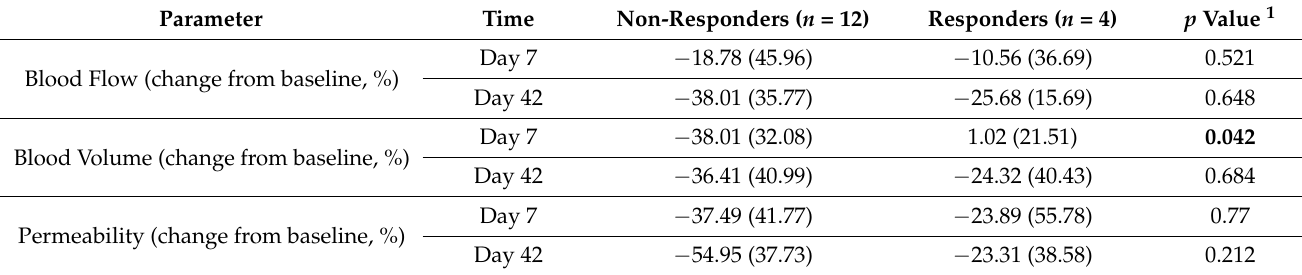
Figure 6. Axial thoracic CT of a 52-year-old man with stage IVa NSCLC showing a lung tumor in the right upper lobe, at baseline ( A ), day +7 ( E ), and day +42 ( I ). Perfusion CT of the lesion with parameters: Blood Flow, BF, (mL/100 mL/min) at baseline ( B ), day +7 ( F ), and day +42 ( J ); Blood Volume, BV, (mL/100 mL) at baseline ( C ), day +7 ( G ), and day +42 ( K ); Permeability, PMB, (mL/100 mL/min) at baseline ( D ), day +7 ( H ), and day +42 ( L ). Color-coded maps and quantification showed an early decrease in BV at day +7 with stable disease according to RECIST at day +42. Table 6. Changes in perfusion parameters in non-responder and responder patients from baseline value. Mean values are shown, with the standard deviation in